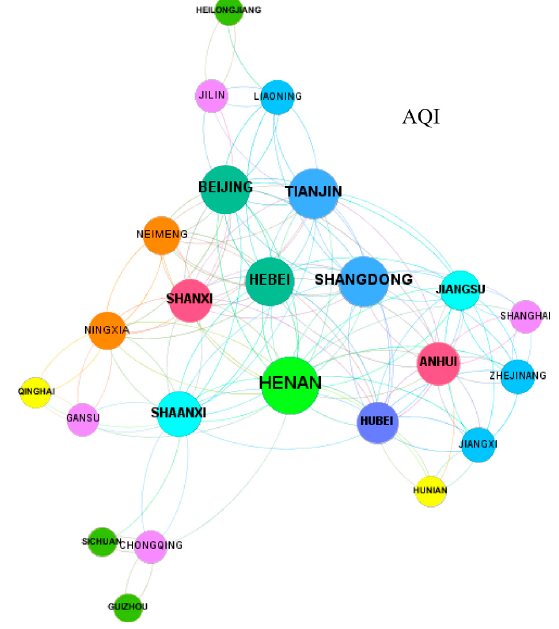
Figure 2. AQI spatial correlation network in 2016.